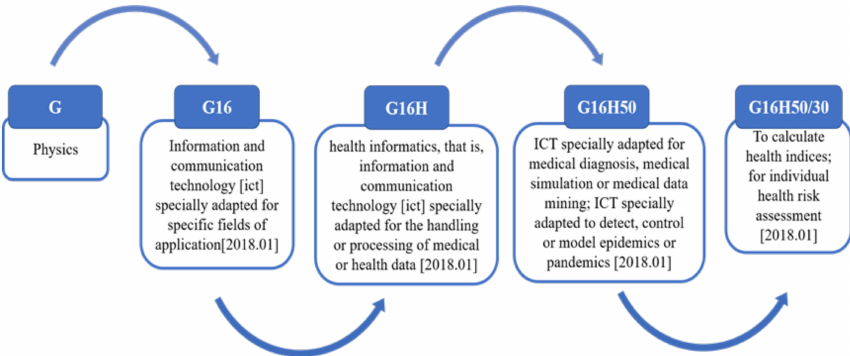
Figure 1. WIPO classification for patents in the area of health and